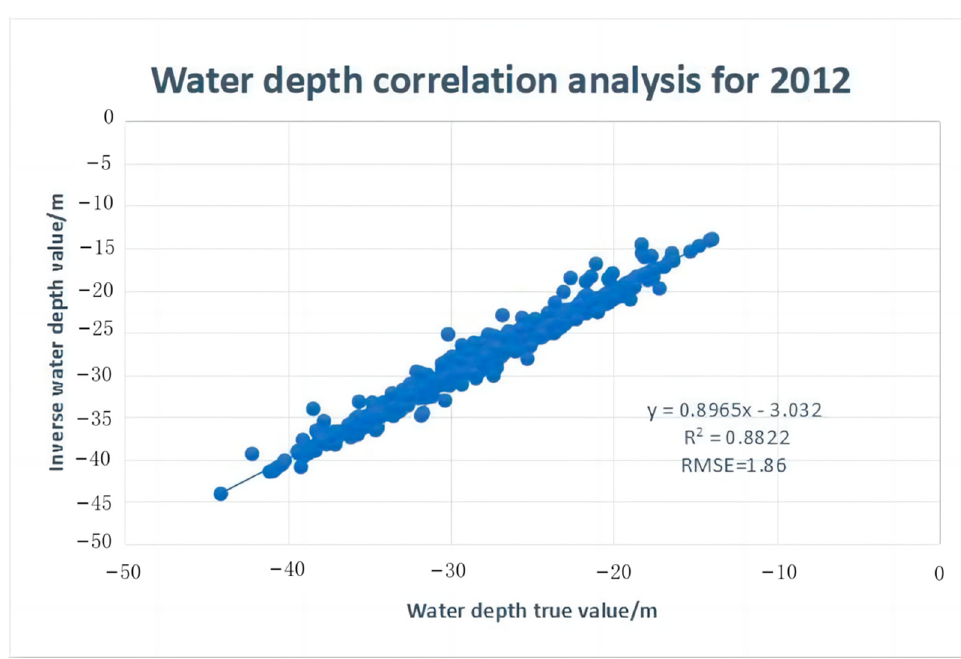
Figure 11. Water depth correlation analysis for 2012.